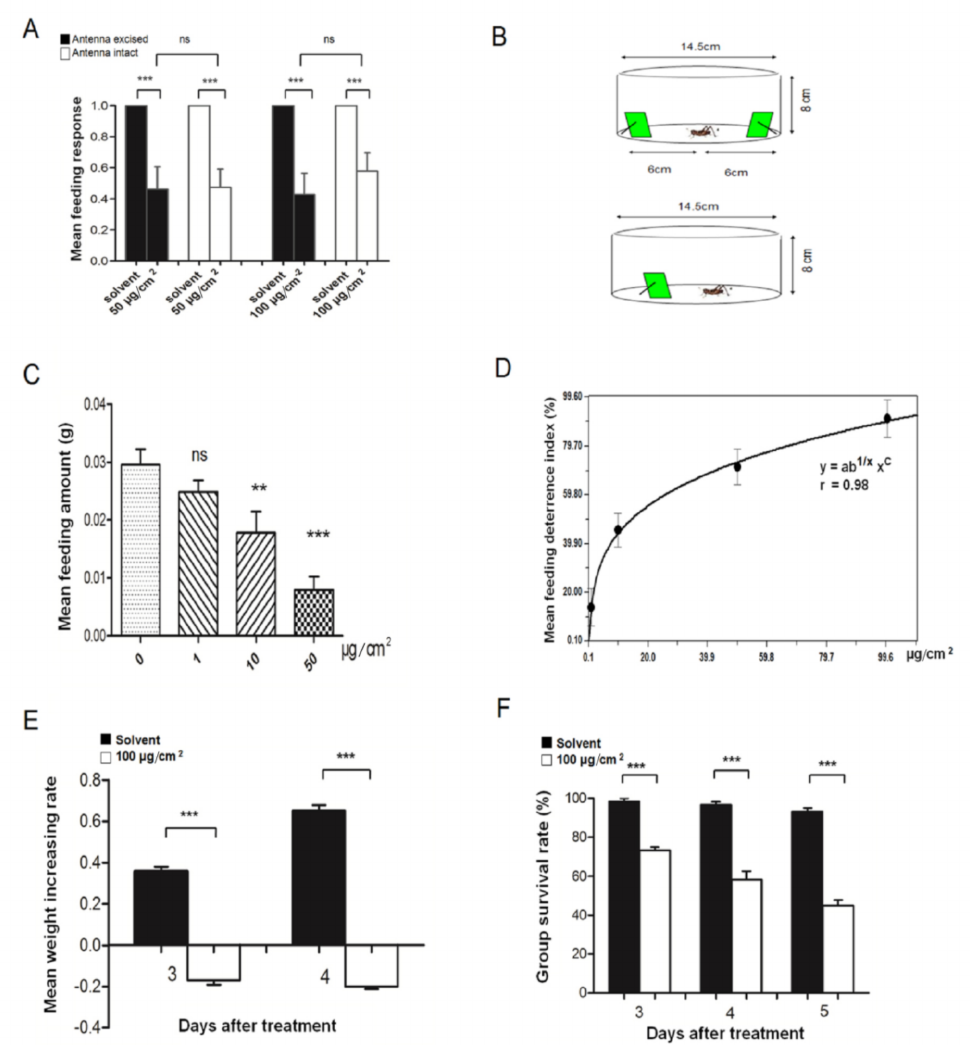
Figure 5. Gustatory perception and biological effects of AMCAL. ( A ) Feeding response of fourth instar nymphs with or without antennae to control and treated leaves (***, p < 0.001, t -test, n ≥ 20; dual-choice test). ( B ) Devices for feeding experiments. Upper, the box used in the dual-choice test; lower, the box used for the non-choice test. ( C ) The mean amount of fourth instar nymphs feeding on leaves spread with AMCAL (**, p < 0.01; ***, p < 0.001, ANOVA, Dunnett test; n ≥ 20; non-choice test). ( D ) Nonlinear regression analyses against feeding deterrence index of fourth instar nymphs ( n ≥ 20; dual-choice test). The mean increase rate of body weight ( E ), or survival rate ( F ) of third instar nymphs after consumption of leaves containing AMCAL at 100 µ g.cm − 2 (***, p < 0.001, t -test; n = 15–20; non-choice test). Each point represents the mean ± S.E.M of three independent replications. ns; no statistically significant